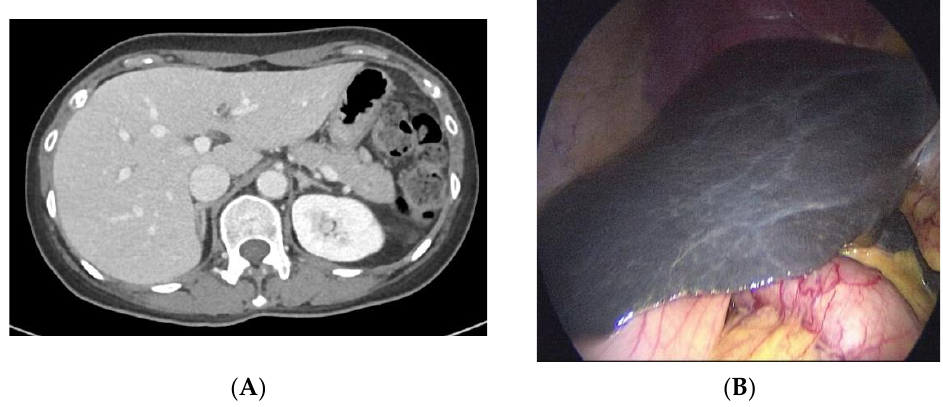
Figure 1. ( A ) Computed tomography findings of liver parenchyma at the time of diagnosis (axial view). ( B ) Gross findings of the patient liver observed during laparoscopic cholecystectomy.